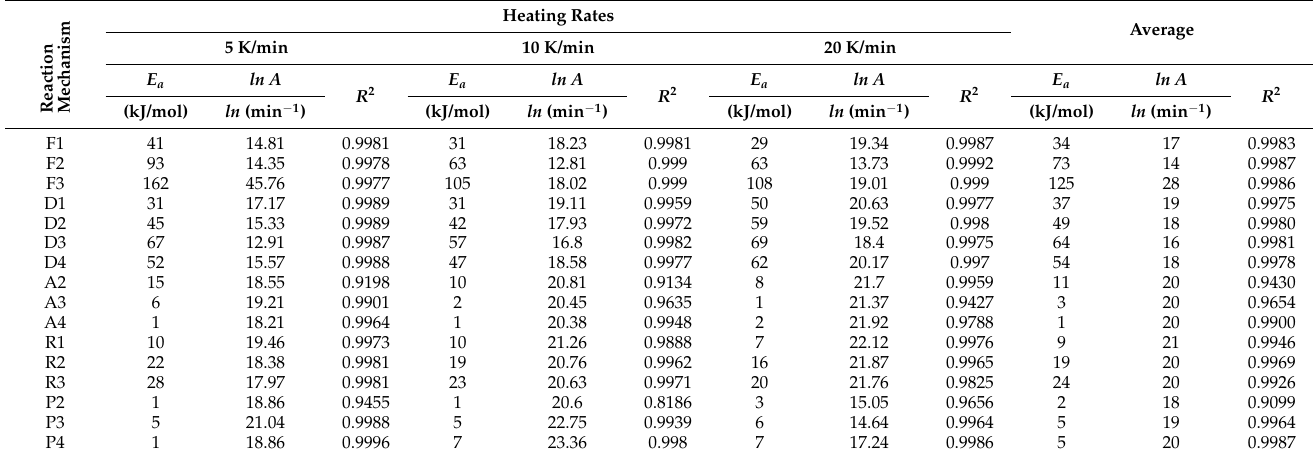
Table 7. Kinetic parameters obtained by Coats-Redfern model for Stage II.